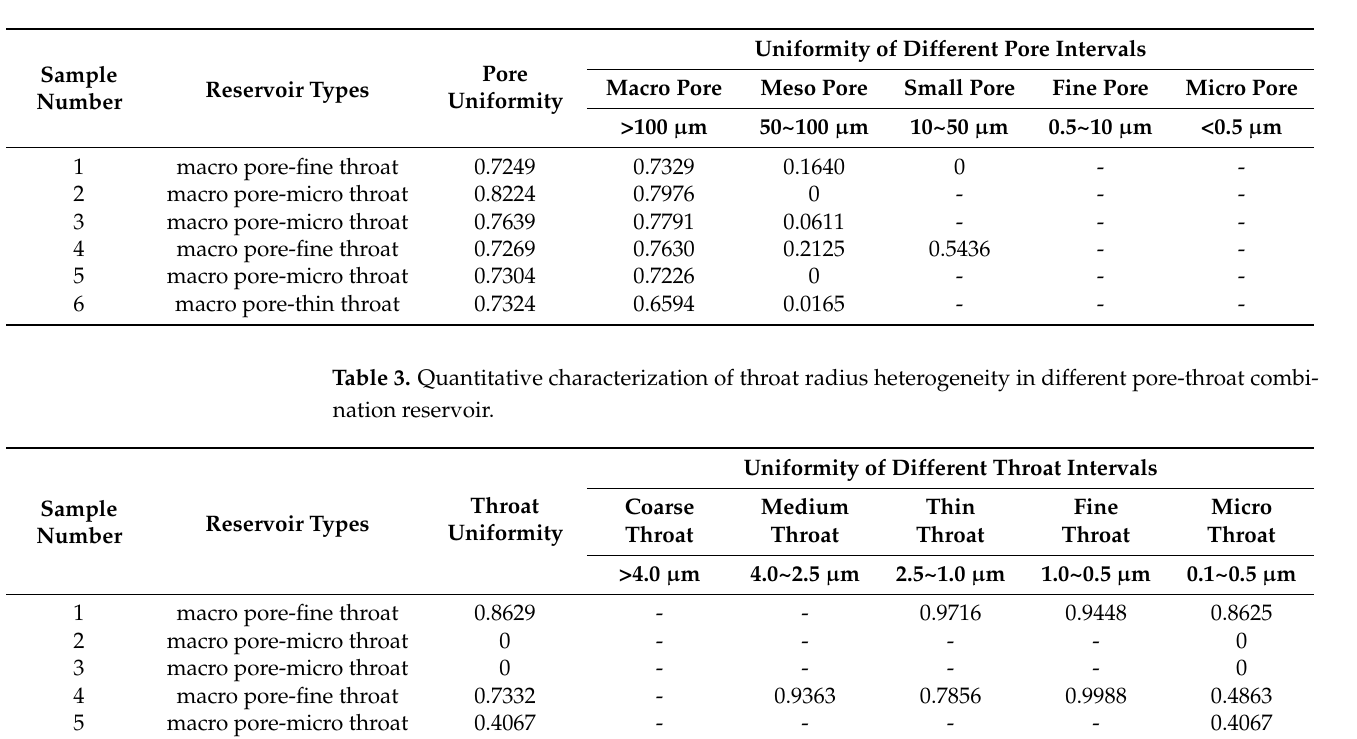
Table 2. Quantitative characterization of pore radius heterogeneity in different pore-throat combina- tion reservoirs.